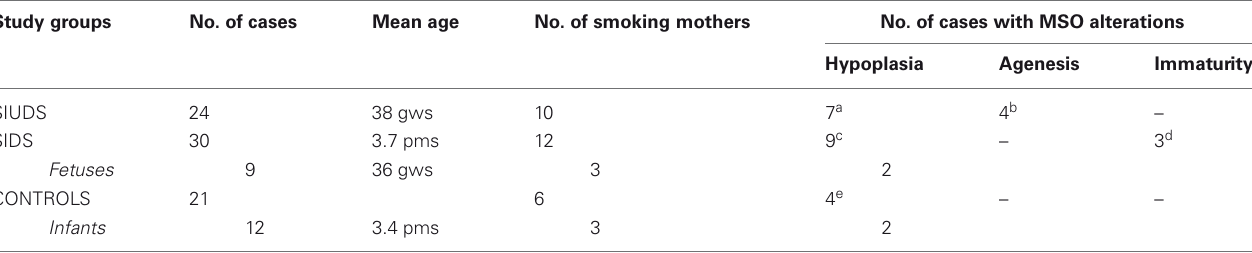
Table 2 | Cases profiles, mother’s smoking habit, and distribution of the MSO alterations. Study